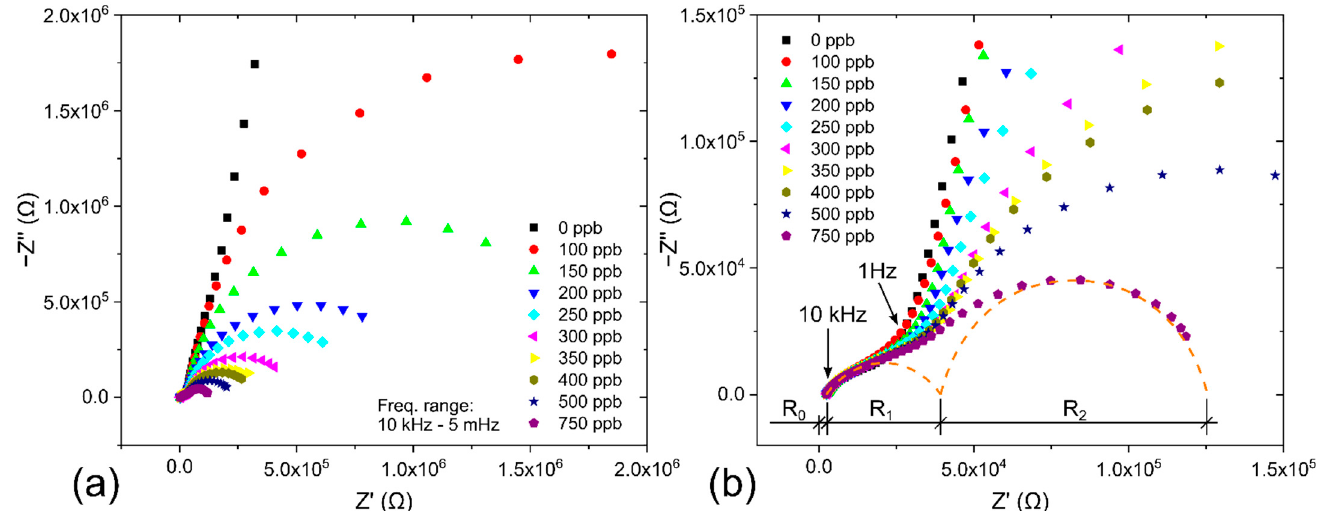
Figure 5. Nyquist plots for the NO 2 sensor (SPE treated at 80 °C for 90 s) with MWCNT-based working electrode for different NO 2 concentrations (operation conditions: 298 K, 40%RH, 1013.25 hPa, analyte flow rate 1 L/min, V BIAS = − 0.5 V): ( a ) Nyquist plot for the whole tested frequency range: 10 kHz–5 mHz, ( b ) Detail of the Nyquist plot for higher frequencies.